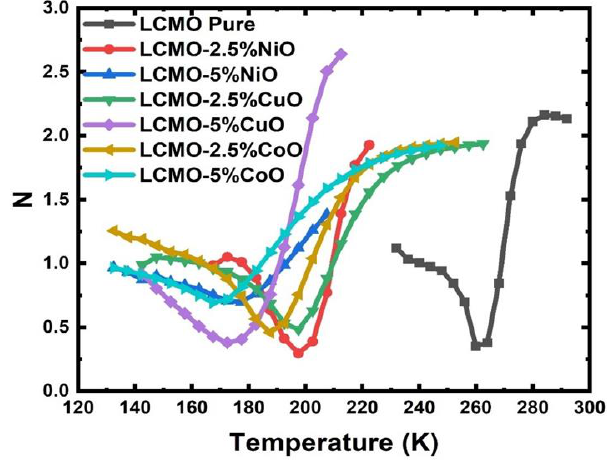
Figure 8. Exponent order N of LCMO – MO composite samples.